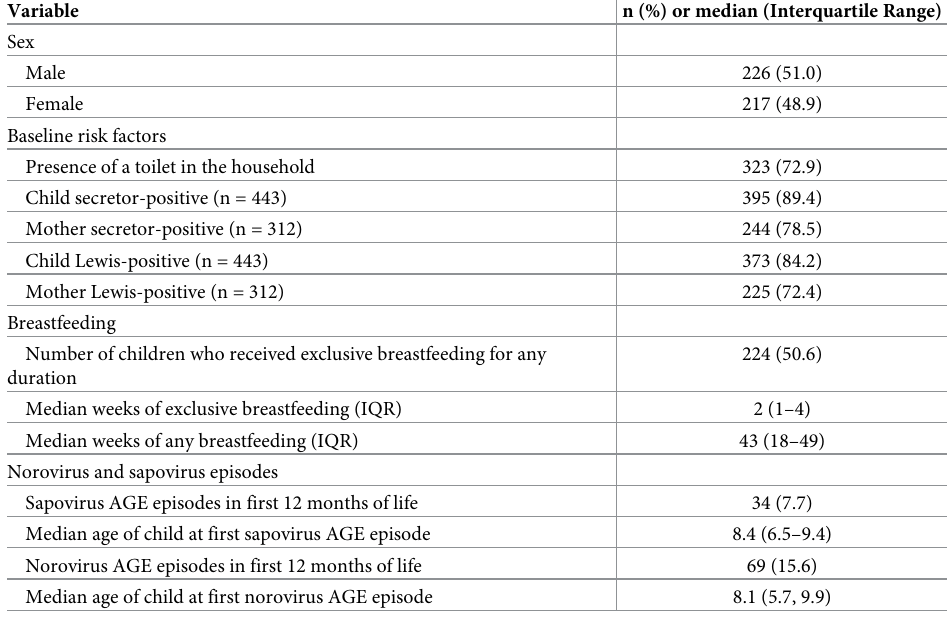
Table 1. Characteristics associated with risk of acute gastroenteritis among children in a Nicaraguan birth cohort (n =